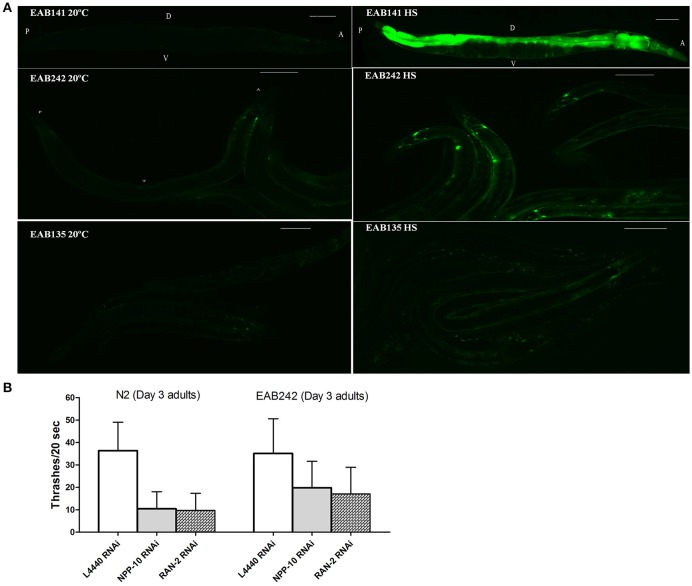
The nuclearpore transportation (NPT) pathway might be impaired in Phsp−16::(G4C2)9/29::GFP transgenic animals. (A) Heat shock-driven expression of Phsp−16::GFP transgenes. Animals were cultured at 20°C and then exposed to 31°C heat shock for 1 h (right panels) or to no heat shock (left panels). GFP was significantly expressed after heat shock in EAB141 animals, but was not much enhanced in EAB242 and EAB135 animals. Transgenic constructs were co-injected with a Pmyo-3::DsRed2 marker. Scale bars are 100 μm. (B) At the L4 stage, N2 and EAB242 animals were treated with NPP-10/NUP98 RNAi and RAN-2 RNAi for 72 h. NPP-10 RNAi reduced thrashes/20 s from 36.3 to 10.4 in N2s and from 35.1 to 19.8 in EAB242s (%Changes: 71.3% vs. 43.6%). RAN-2 RNAi reduced the thrashes to 9.7 in N2s and 17.1 in EAB242s (%Changes: 73.3% vs. 51.3%). L4440 control RNAi did not affect thrashes (36.3 and 35.1 of N2 and EAB242, respectively).